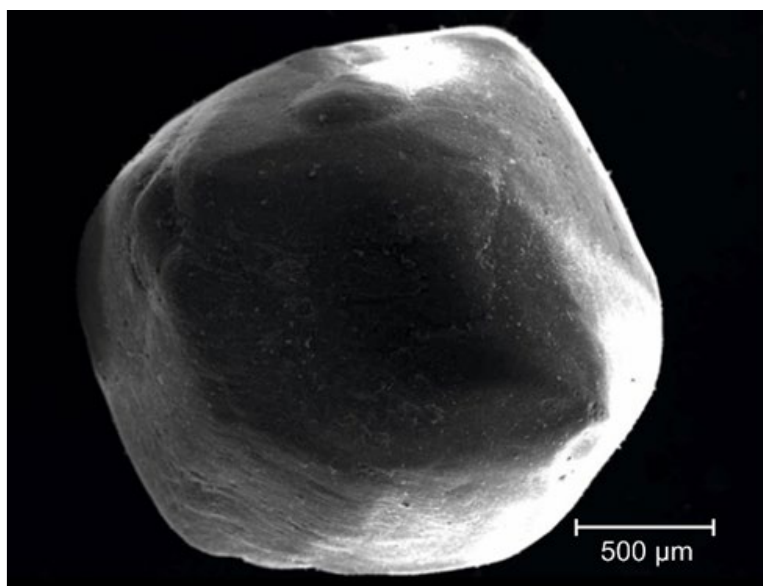
Figure 5. Rhombic dodecahedron shape of the demantoid crystal from the Poldnevskoye deposit. SE image.